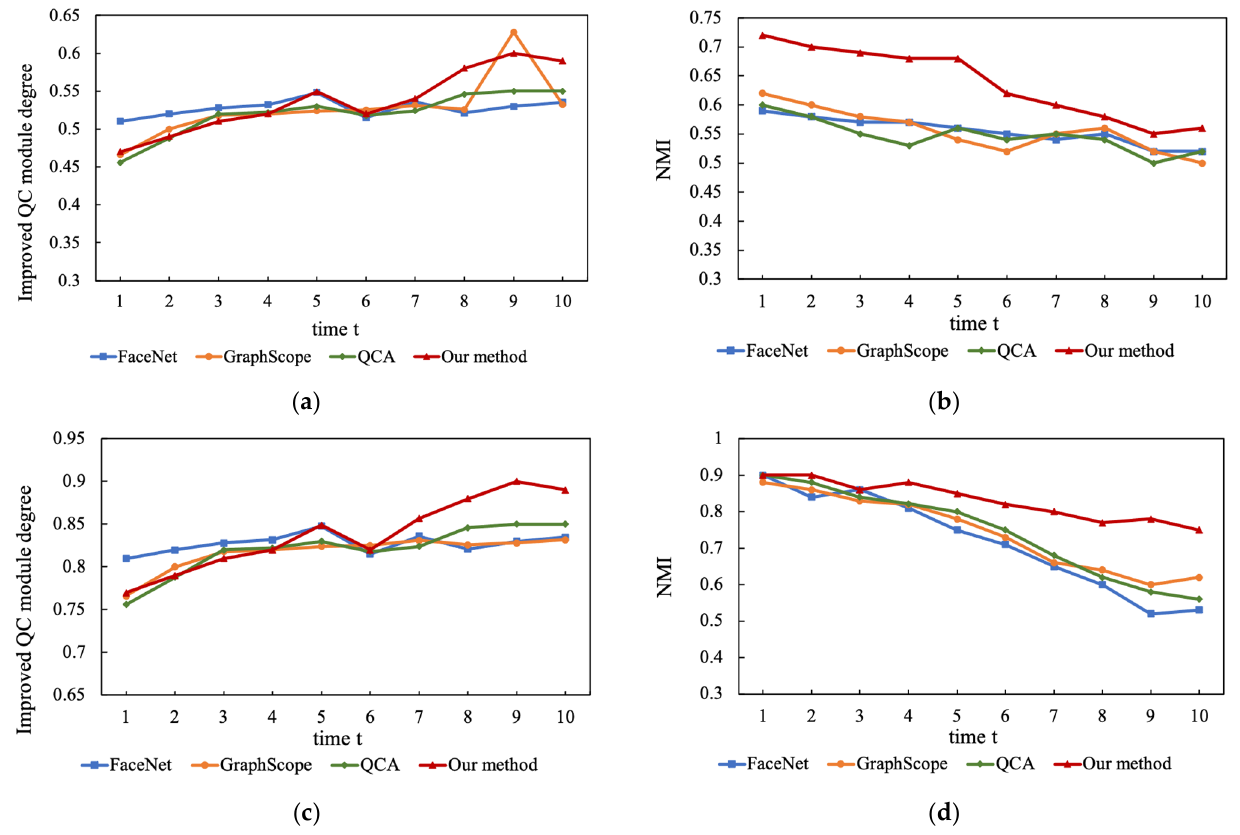
Figure 7. Running time of the four algorithms on the two datasets after manual processing. ( a ) Cora; ( b ) Wiki.